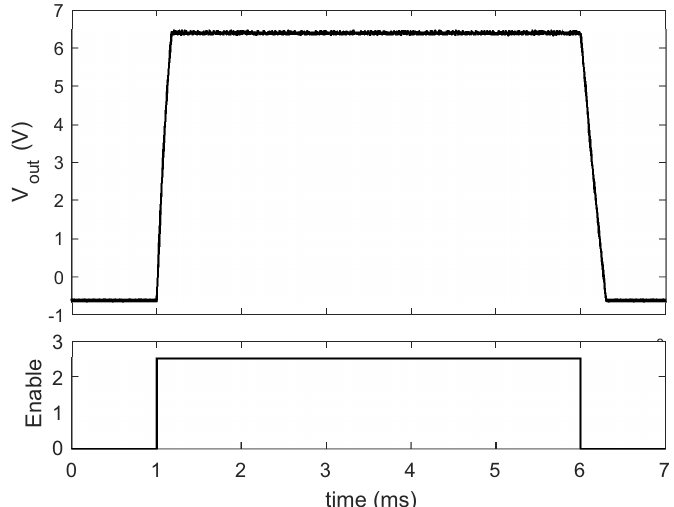
Figure 10. Measured transient response of the proposed closed-loop charge pump under 40 µ A